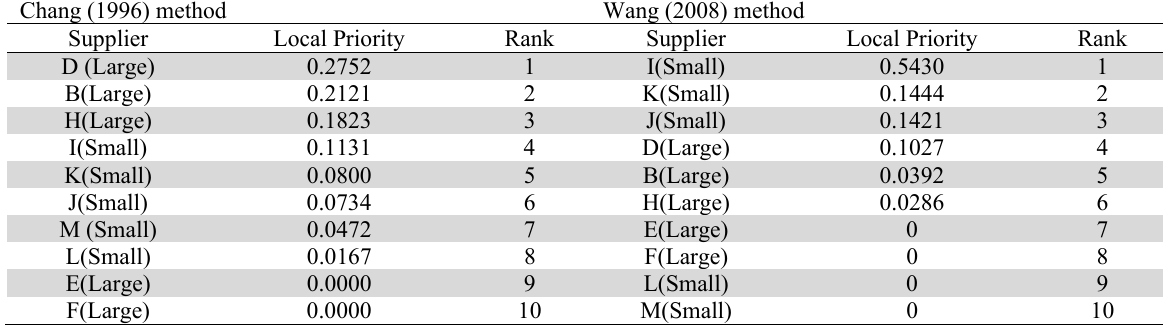
Comparison of Local Priority Obtained by Chang (1996) and Wang (2008)